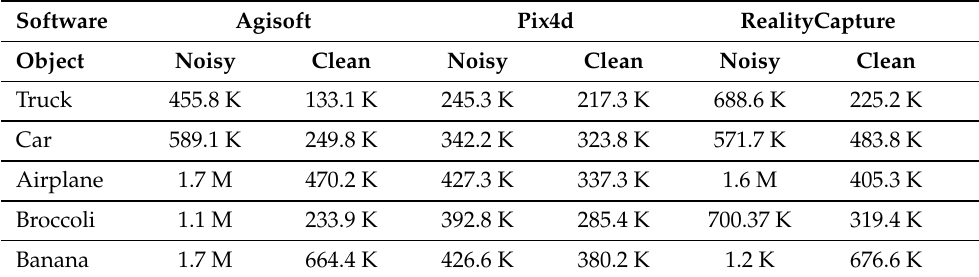
Figure 8. Example results using RealityCapture for various models showing the four resulting point clouds from out experiments. Ctrl—using controlled environment, Ref—hand cleaned version of Ctrl, Msk—uncontrolled environment masked using our pipeline, Unctrl—uncontrolled environment. Table 2. Number of points before and after noise